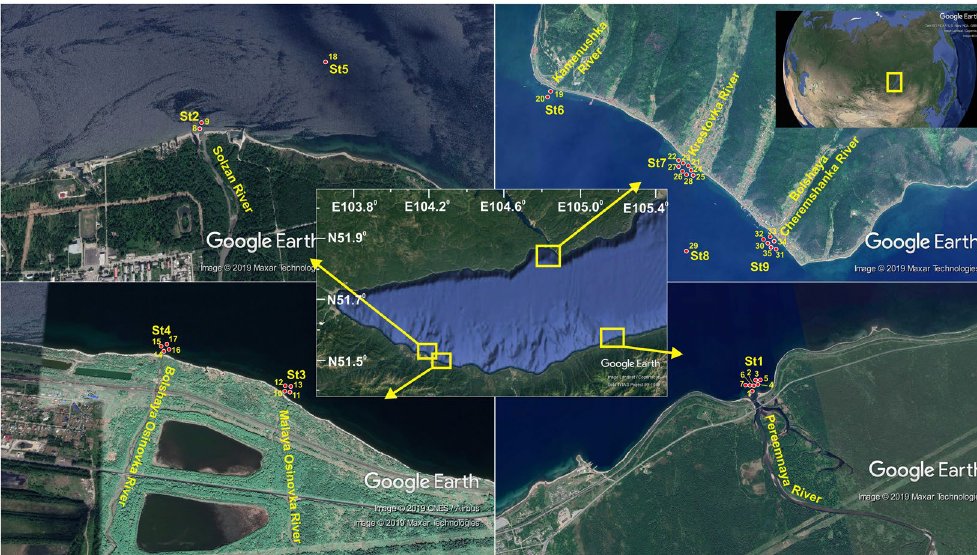
Figure 1. Map of the sampling sites. Sample numbers correspond to the numbers in in the table with the initial data (https://github.com/barnsys/bac_phyt_communities). Geographic coordinates of stations (degrees and decimal places): St1 51.56891 N, 105.16609; St2 51.49722 N, 104.15836 E; St3 51.50056 N, 104.25354 E; St4 51.50056 N, 104.24403 E; St5 51.53875 N, 104.19746 E; St6 51.84457 N, 104.87505 E; St7 51.85535 N, 104.85970 E; St8 51.86710 N, 104.83247 E; St9 51.84429 N, 104.83949 E. Maps were taken from the Google Earth Pro software (https://www.google.com/intl/ru/earth/versions/#earth-pro). «Inkscape» (https://inkscape.org/) free graphics editor was used to edit images and apply additional marks to maps.